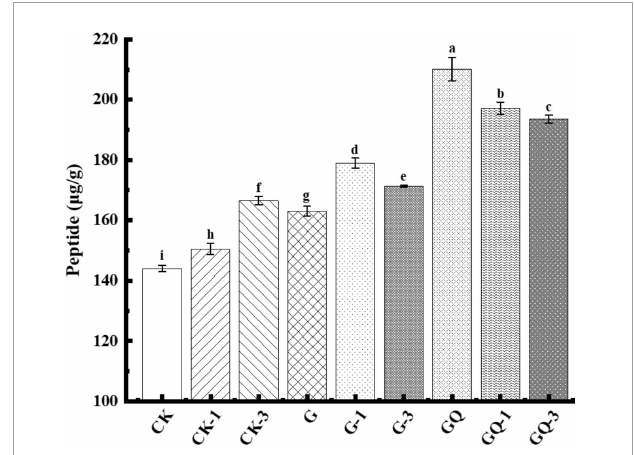
FIGURE5 Peptide content of sausage among treatments at the end of fermentation (28 days). Different lowercase letters (a–i) indicate a significant difference between different treatment groups ( P < 0.05). The group without starter culture and leucine was assigned to the CK group. The groups added with 1 and 3 mM of leucine without starter culture were assigned to the CK-1 and CK-3 groups, respectively. The group with Lactobacillus fermentum YZU-06 was assigned as the G group. The groups with Lactobacillus fermentum YZU-06 and different concentrations of leucine (1 and 3 mM) were named G-1 and G-3 groups, respectively. The fermented sausage with the mixed-starter cultures of Lactobacillus fermentum YZU-06 and Staphylococcus saprophyticus CGMCC 3475 was assigned to the GQ group. The groups with the mixed-starter cultures and different concentrations of leucine (1 and 3 mM) were named GQ-1 and GQ-3 groups,